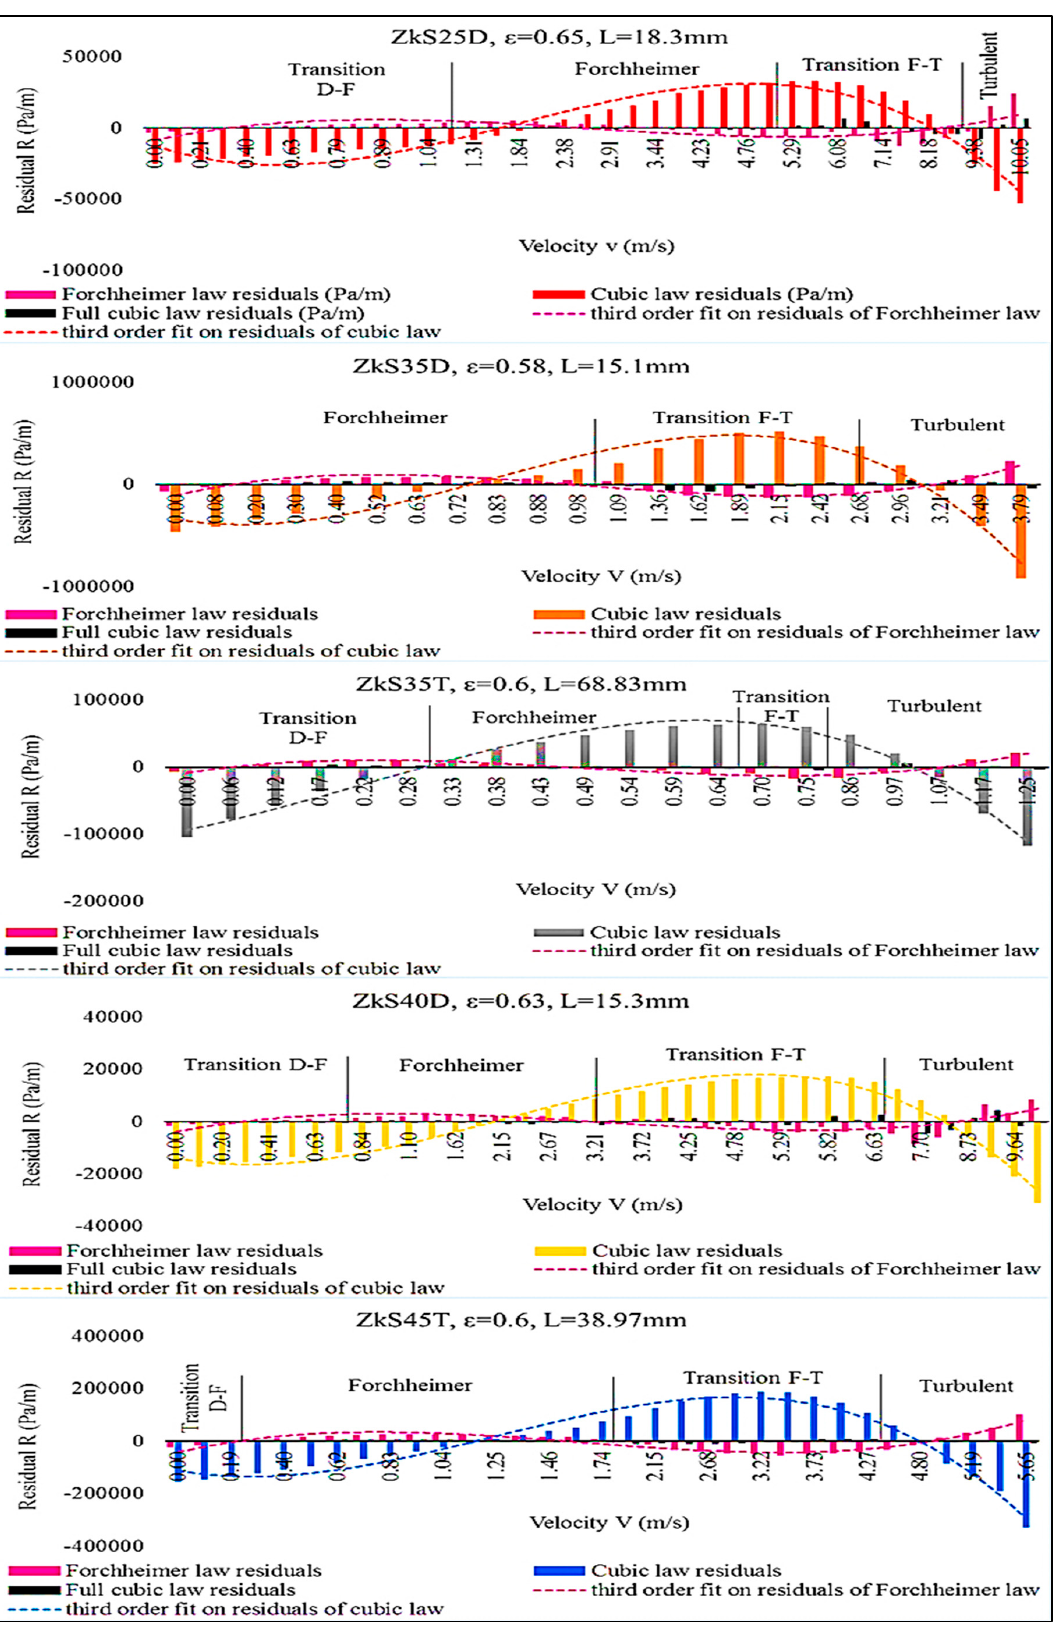
Figure 7. Comparison between Forchheimer, cubic, and full cubic law residuals for each ESR sample.